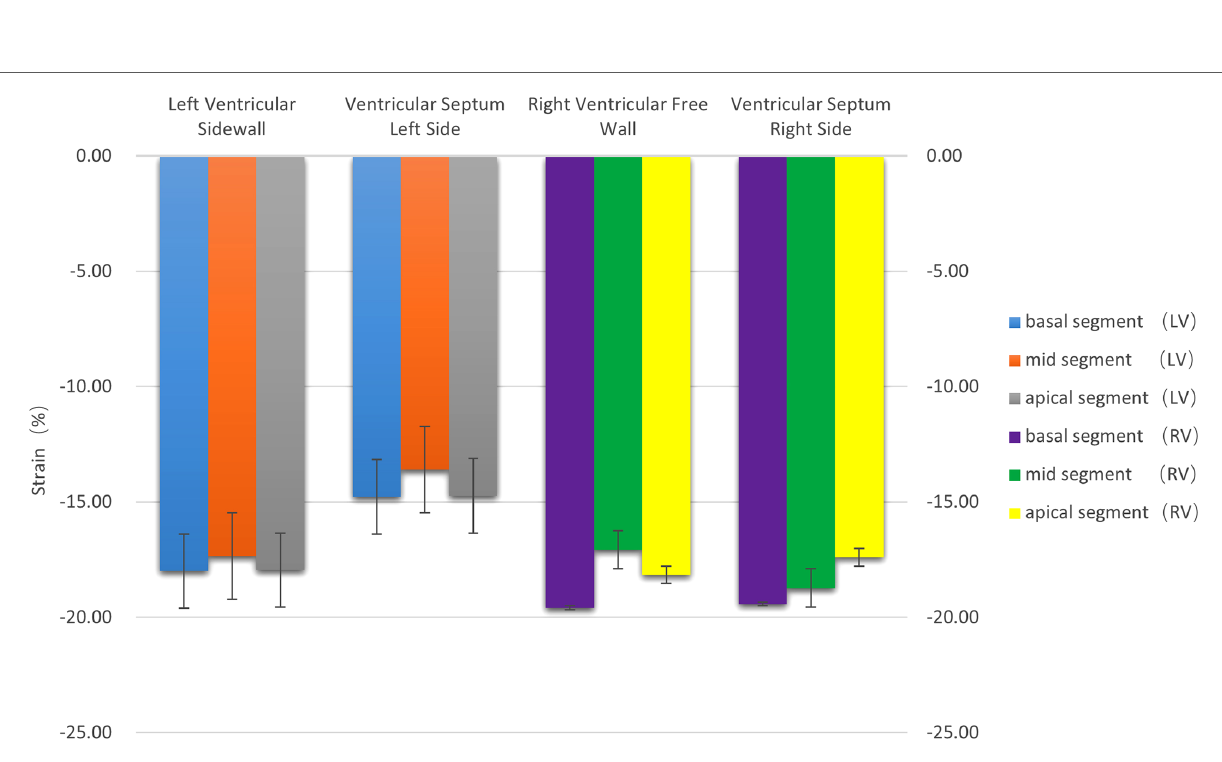
(2) Strain: There were no statistically signi fi cant differences in the correlation between the strain and the gestational age ( P > 0.05).